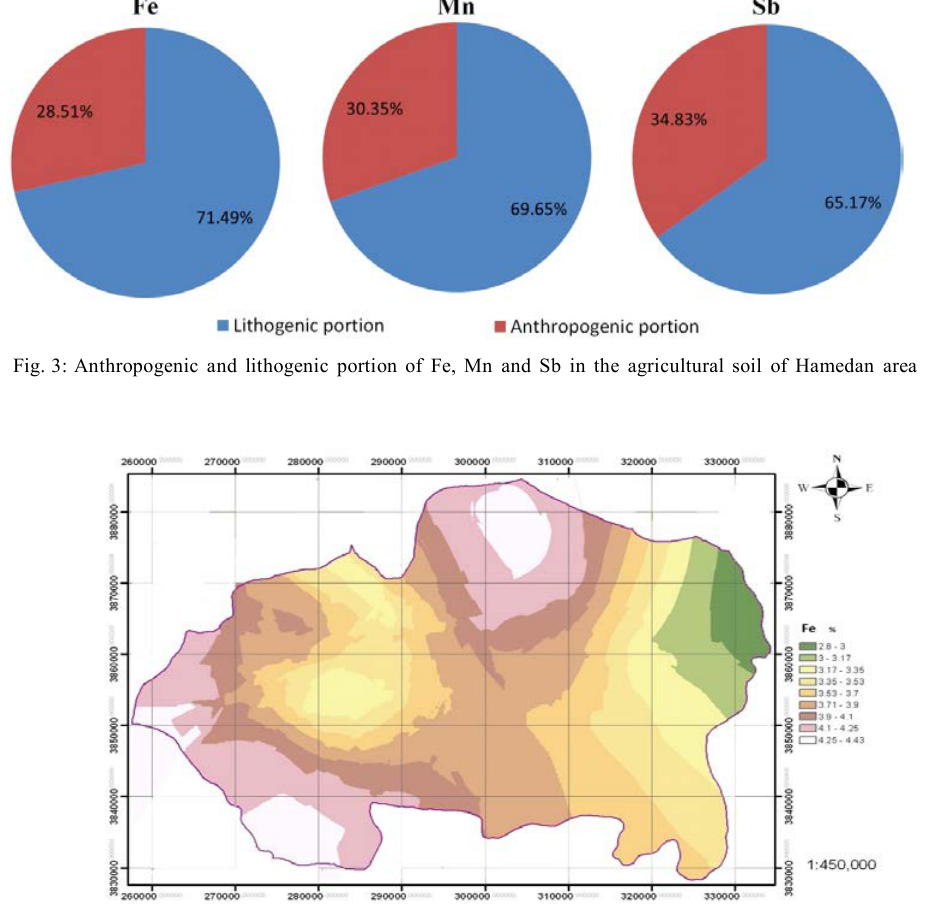
Fig. 4: Spatial distribution of iron in the soil of Hamedan